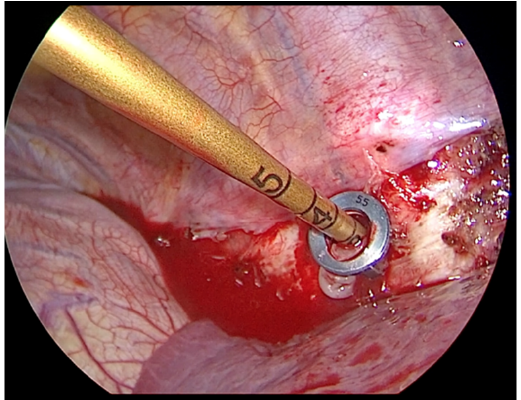
Figure 7. Insertion of the screws must take place perpendicularly to the vertebral body.